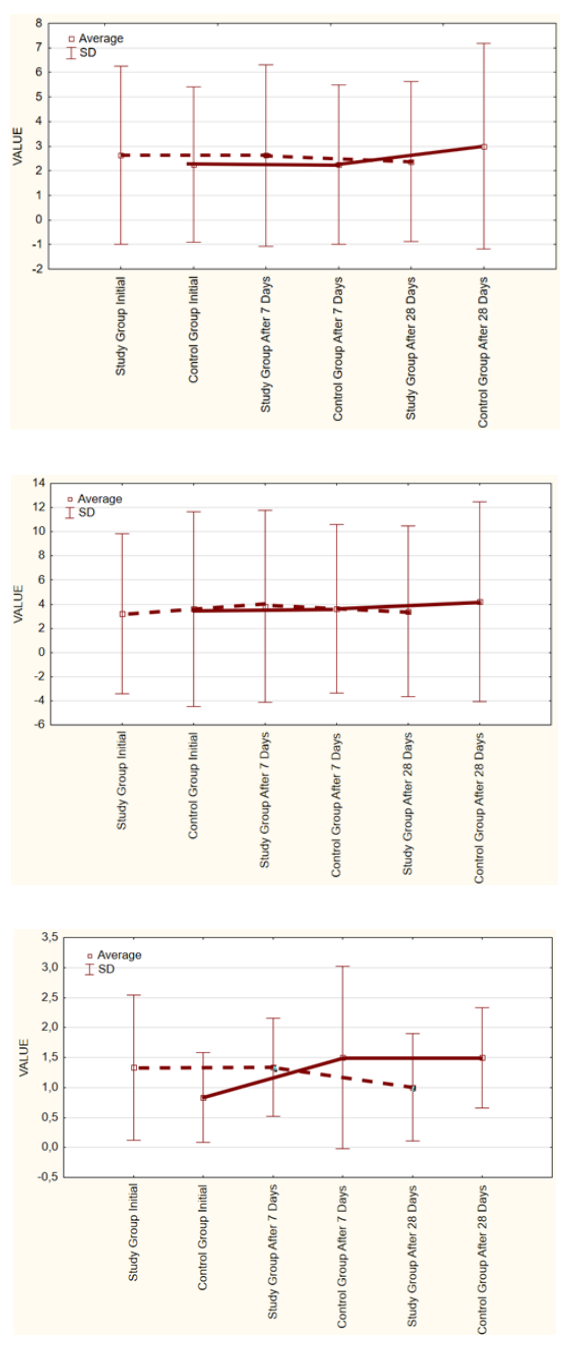
Figure 5. Estimated marginal means for microorganism strains in the study and control groups (initial, after 7 days, and after 28 days): ( A ) — Gram(+) anaerobic bacteria; ( B ) — Gram(-) anaerobic bacteria; ( C ) — Gram(+) aerobic bacteria; ( D ) — Gram( − ) aerobic bacteria; ( E ) — fungi. Table 6. Changes of oral microbiota in patients using the toothpaste with EEP and TTO (study group) or without EEP and TTO (control group).